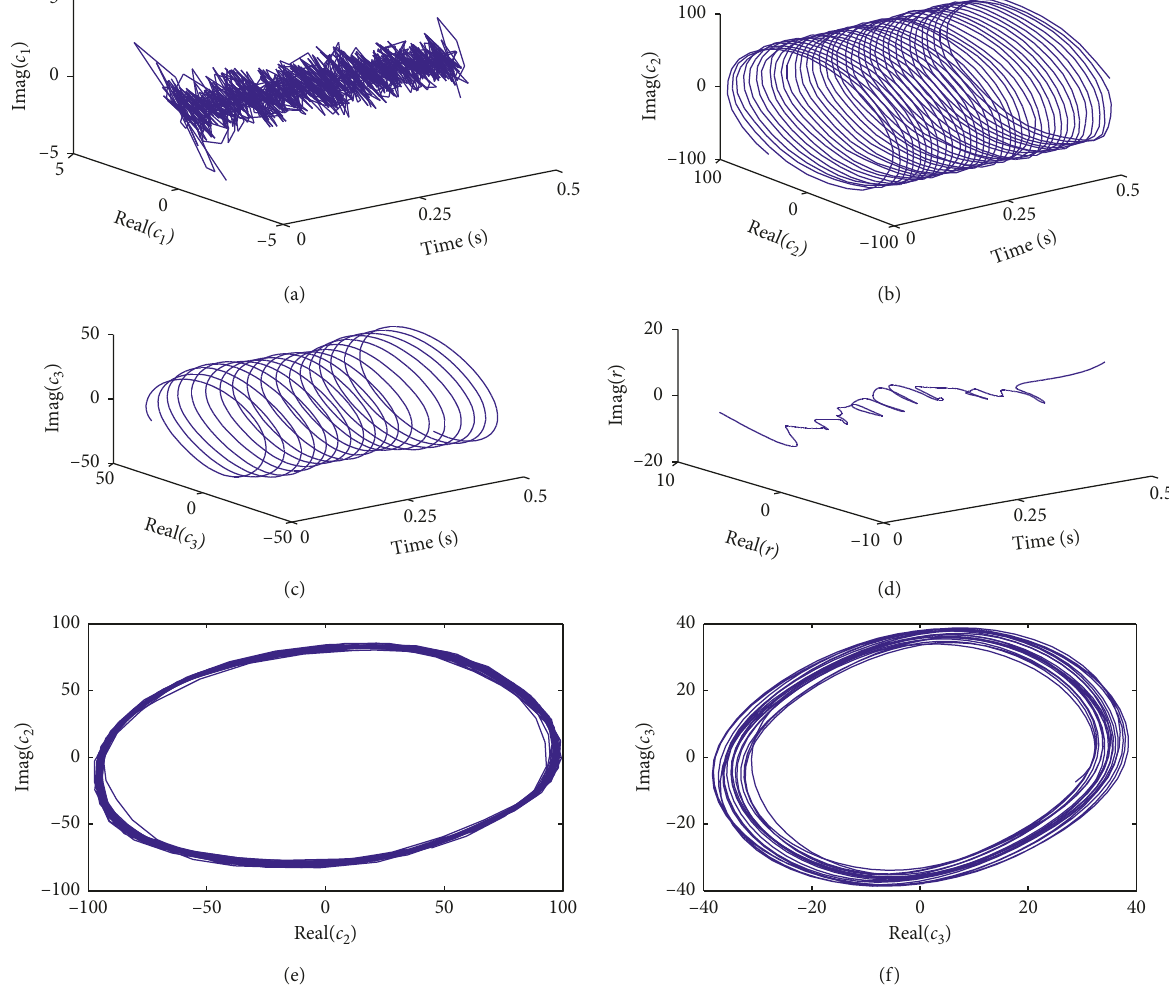
Figure 16: The decomposition results of the oil whirl signal based on the improved BEMD